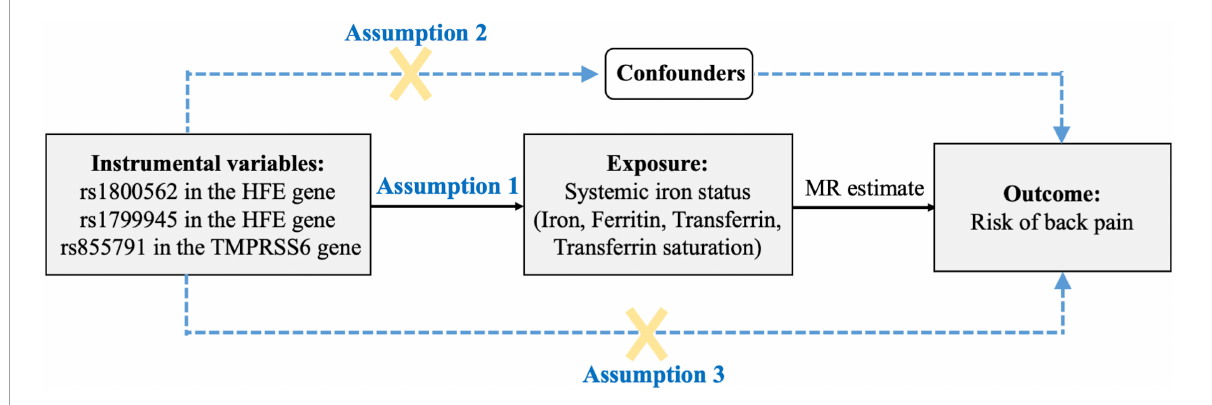
FIGURE1 The design flow chart for the Mendelian randomization (MR) study. Assumption 1: Genetic instrumental variables are associated with systemic iron status with the genome-wide significance; Assumption 2: Genetic instrumental variables are not associated with any measured and unmeasured confounders; Assumption 3: Genetic instrumental variables do not influence the risk of back pain through other pathways. MR, Mendelian randomization.